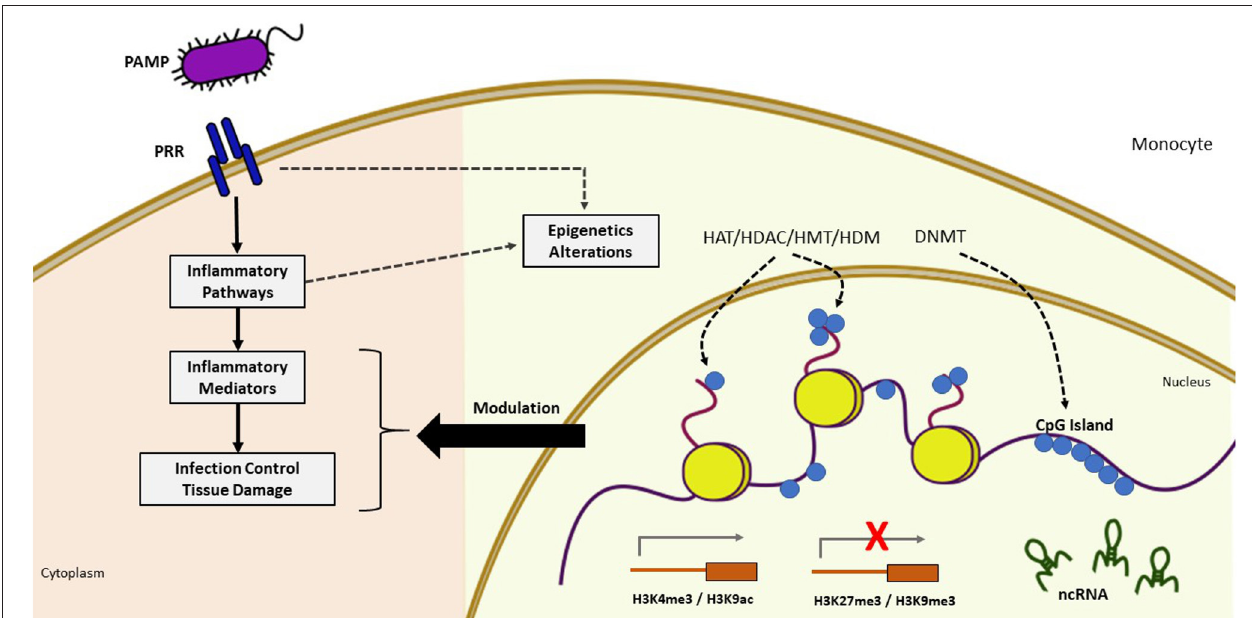
FIGURE 2 | Epigenetic modifications during infection. Pathogen recognition by PRR triggers cascades of intracellular signaling activating inflammatory mediators which induces dynamic changes in chromatin through epigenetic mechanisms, leading to increased or decreased gene activation. The pathogen can also directly alter chromatin through the influence of epigenetic modifiers. These epigenetic alterations (yellow background) may modulate the inflammatory response (pink background). Sepsis induces profound changes in gene expression involved in the inflammatory process and host defense. Epigenetic modifications play a central role in its regulation as evidenced by the presence of differentially methylated CpG islands, several modifications of histones with effects on gene activation (H3K4me, H3K9ac) and repression (H3K27me3, H3K9me3), and the presence of differentially expressed ncRNAs. PAMP, pathogen-associated molecular pattern; PRR, pattern recognition receptor; DNMT, DNA methyltransferase; HAT, histone acetyltransferase; HDAC, histone deacetylase; HDM, histone demethylase; HMT, histone methyltransferases; ncRNA, non-coding